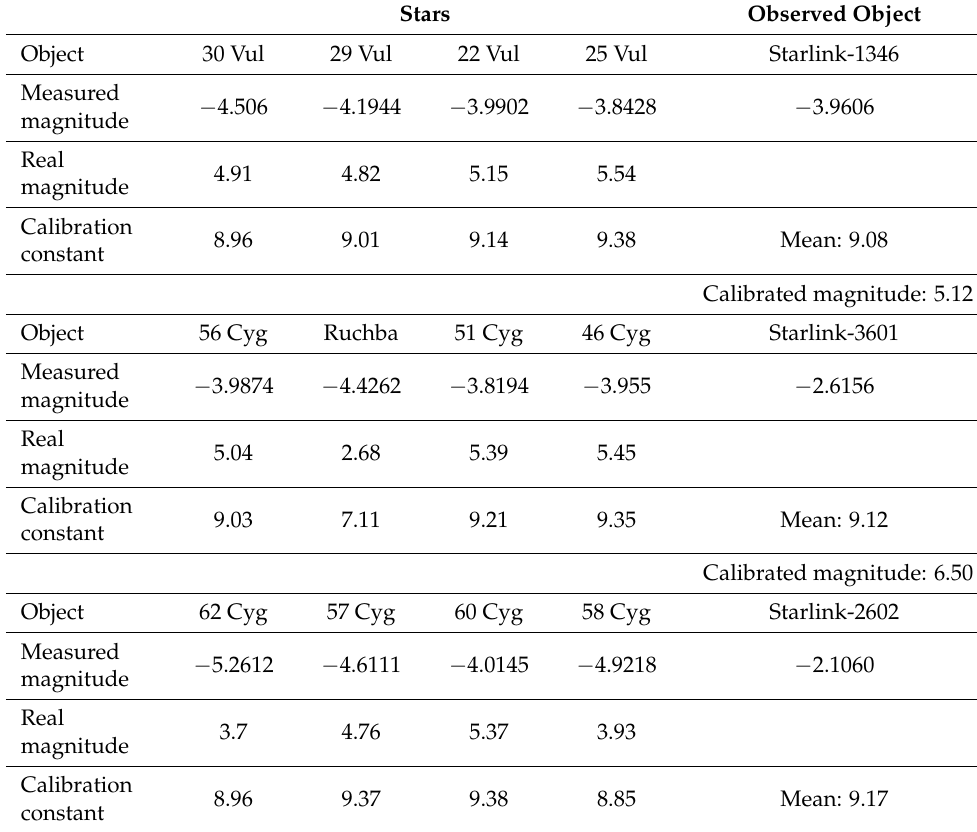
Table 3. Measured magnitudes for the observed objects. Stars Observed